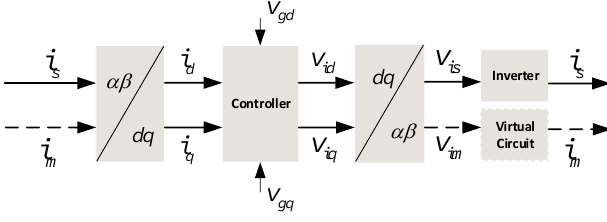
Figure 2. Improved control diagram for a single-phase inverter.